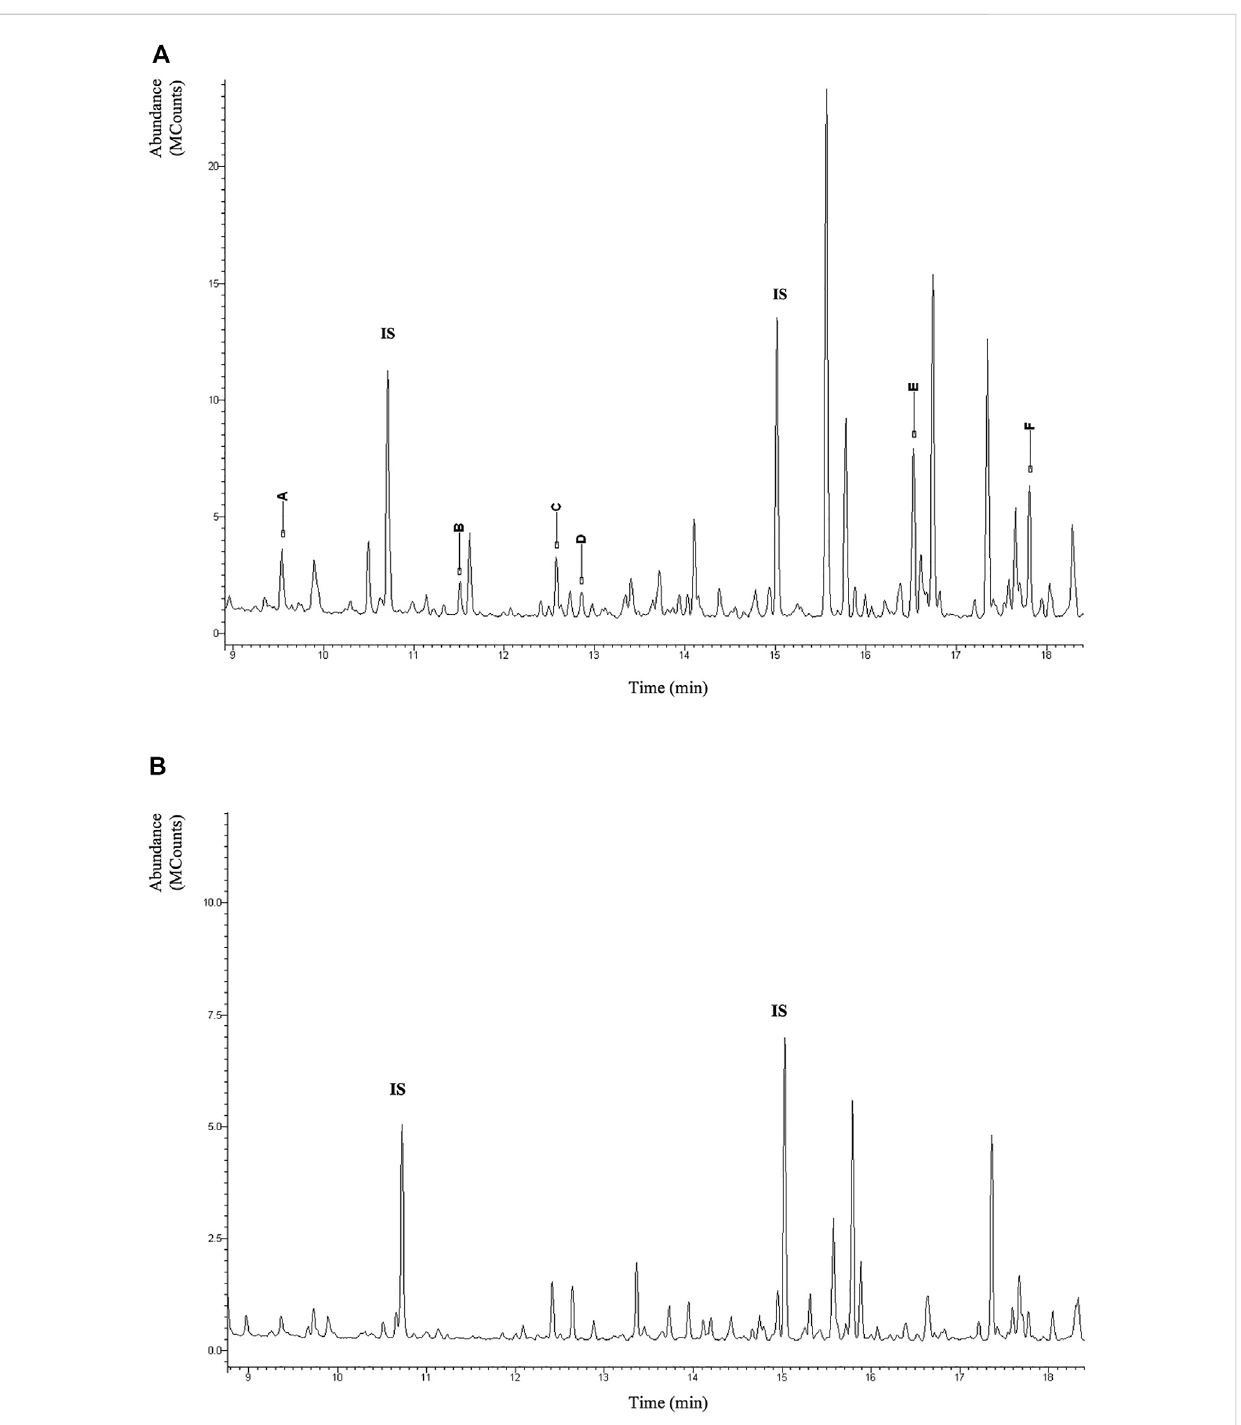
FIGURE 3 Sectionofthetotal-ionchromatogramofurinaryorganicacidofthepatientafterextractionwithethylacetateandderivatizationwithBSTFA+TMCS (1%) at 60 ° C for 30 min. IS (Internal Standard). In the fi gure the TMS derivatives of the N-acetylated amino acids are highlighted with capital letters: (A) N-acetyl-alanine; (B) N-acetyl-glycine; (C) N-acetyl-leucine; (D) N-acetyl-isoleucine; (E) N-acetyl-methionine; (F) N-acetyl-glutamate (A) . Normal pattern (B)